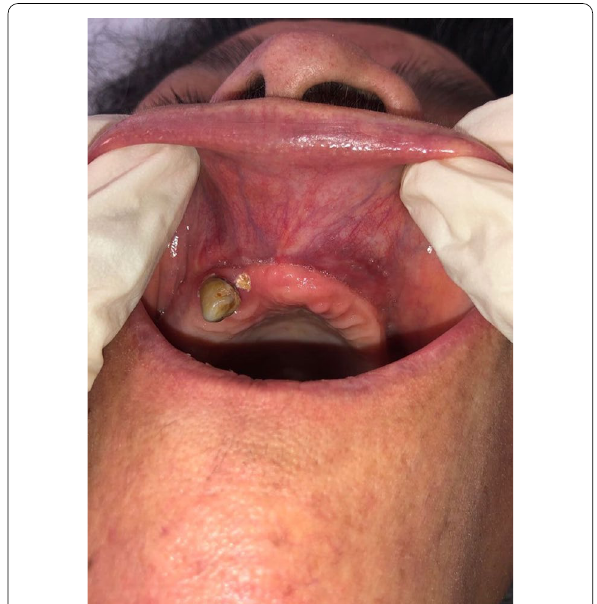
Fig. 1 İntraoral view of the